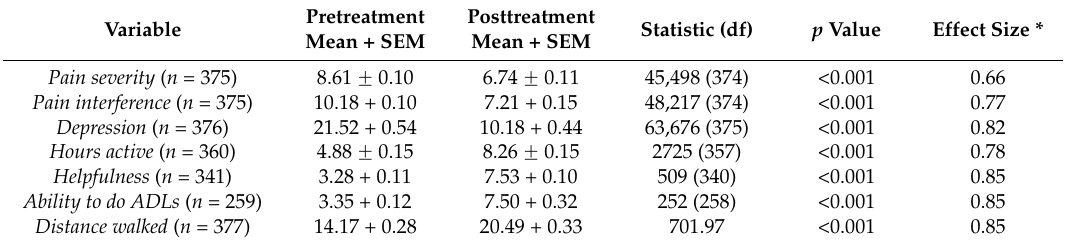
Table 3. Comparison of pre- and post- program treatment outcomes using Wilcoxon signed rank tests. Variable